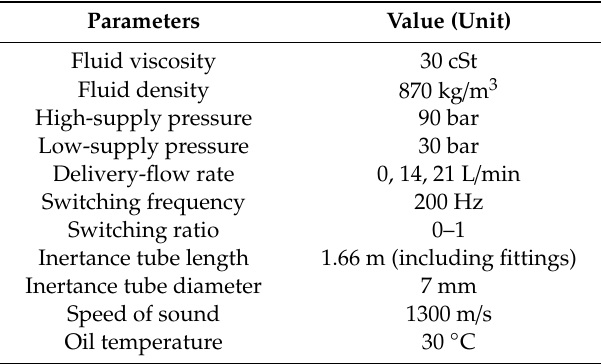
Table 1. Parameters for analytical model and experiments.